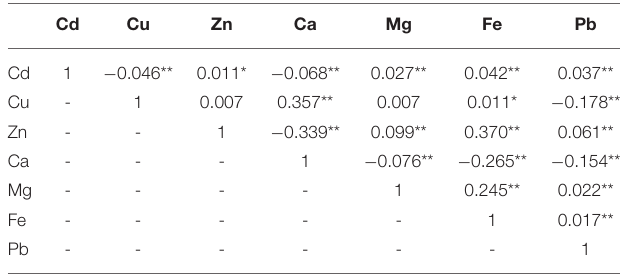
TABLE 3 | Correlation coefficient between different elements (r-value) ( n =